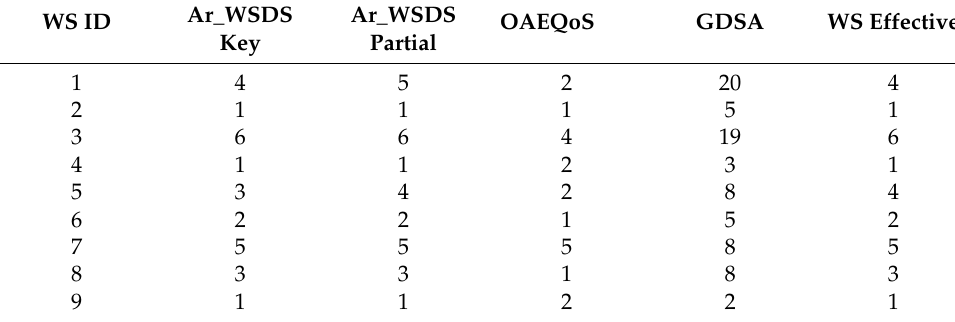
Table 8. Test results of the WS